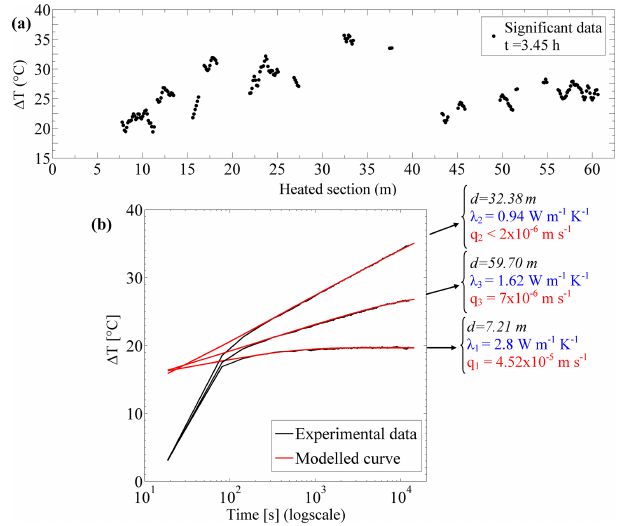
Figure 7. (a) Significant (cid:49)T values measured 3.45h after the start of the heating period measured along the buried FO section. (b) Ex- amples of data interpretation on three thermal response curves ob- served in the data (black lines). The MILS model was used to re- produce the temperature increase during both the conduction- and advection-dominant periods (red